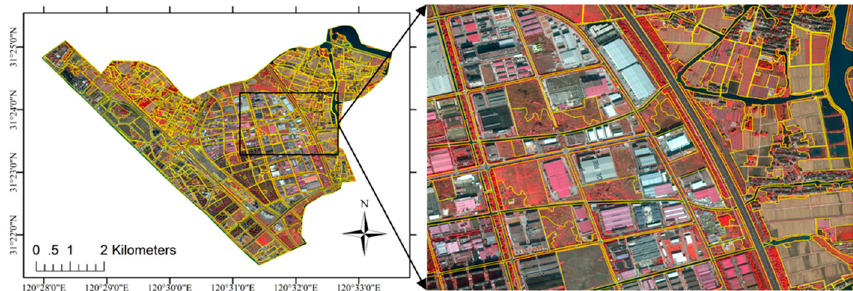
Figure 7. The precise boundaries of extracted geo-objects for the target image.